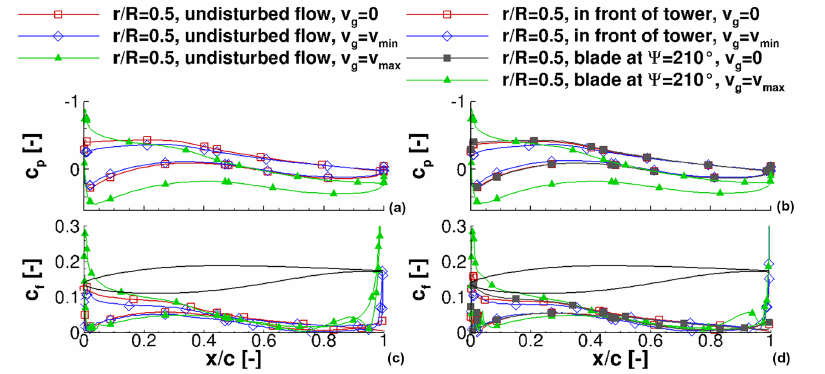
Figure 9. Pressure distribution of the blade at the midsection, (a, c) undisturbed flow, and (b, d) with tower blockage; (a, b) pressure distribution and (c, d) friction force